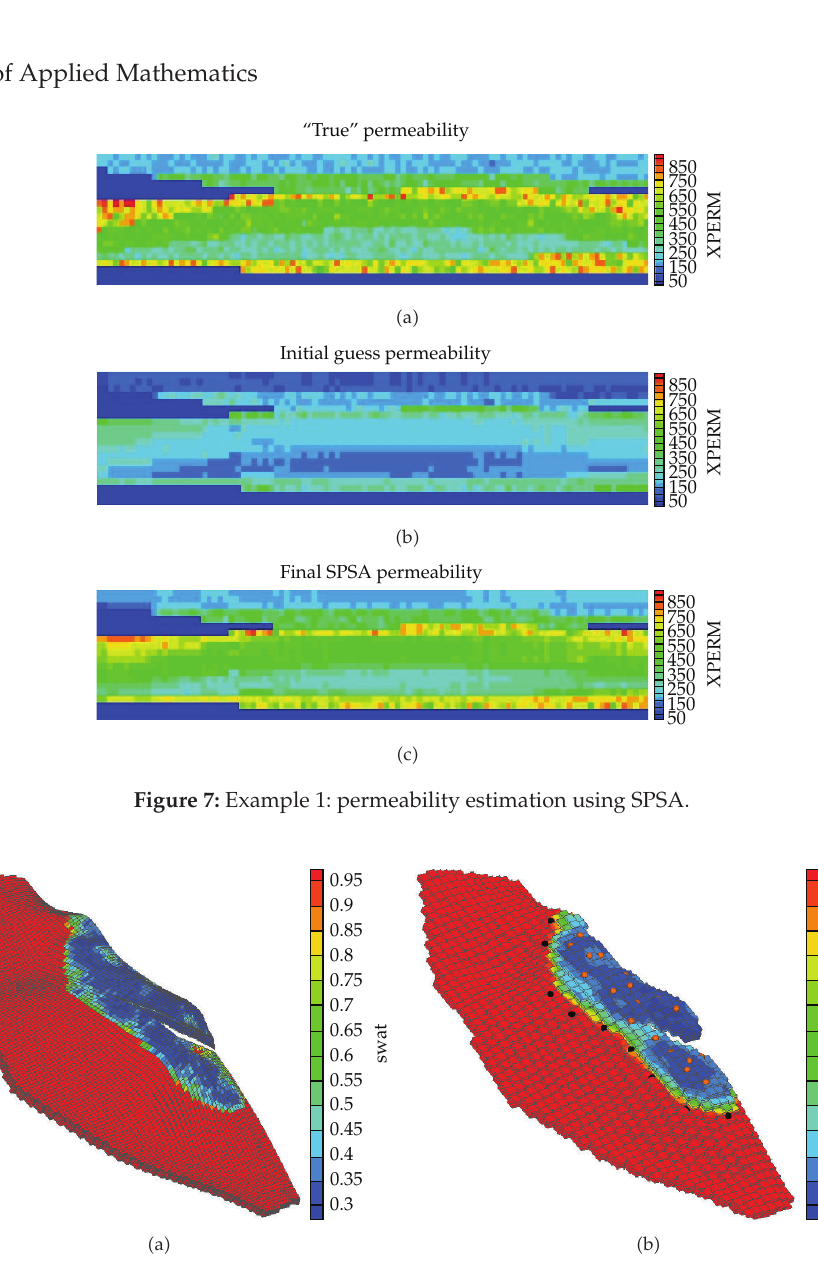
Figure 8: Example 2 (cid:6) Brugge field (cid:7) : true (cid:6) a (cid:7) , approximate (cid:6) b (cid:7) geometry with initial water saturation and grid